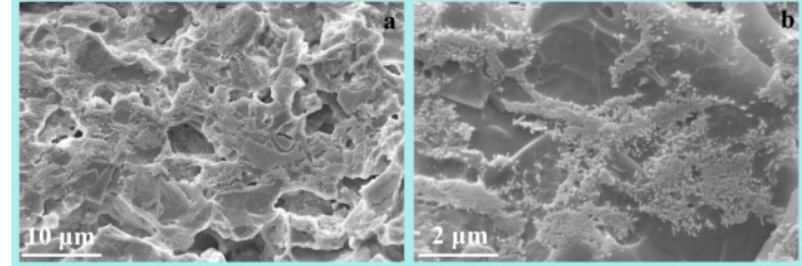
Figure 4. SEM images of R with different scale bar (( a ) 10 μ m; ( b ) 2 μ m) at 1603 K.